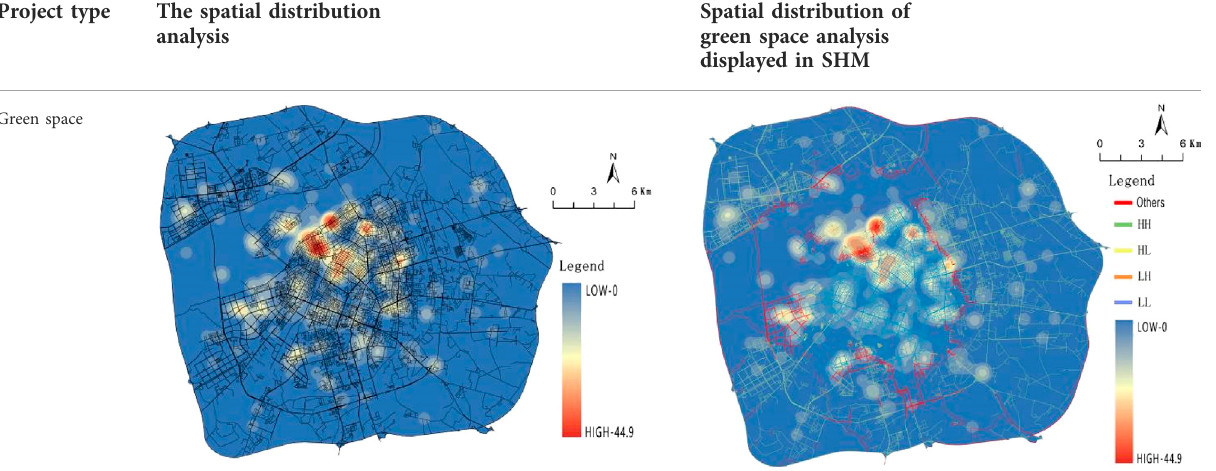
TABLE 8 Spatial distribution of single infrastructure (Green space) in